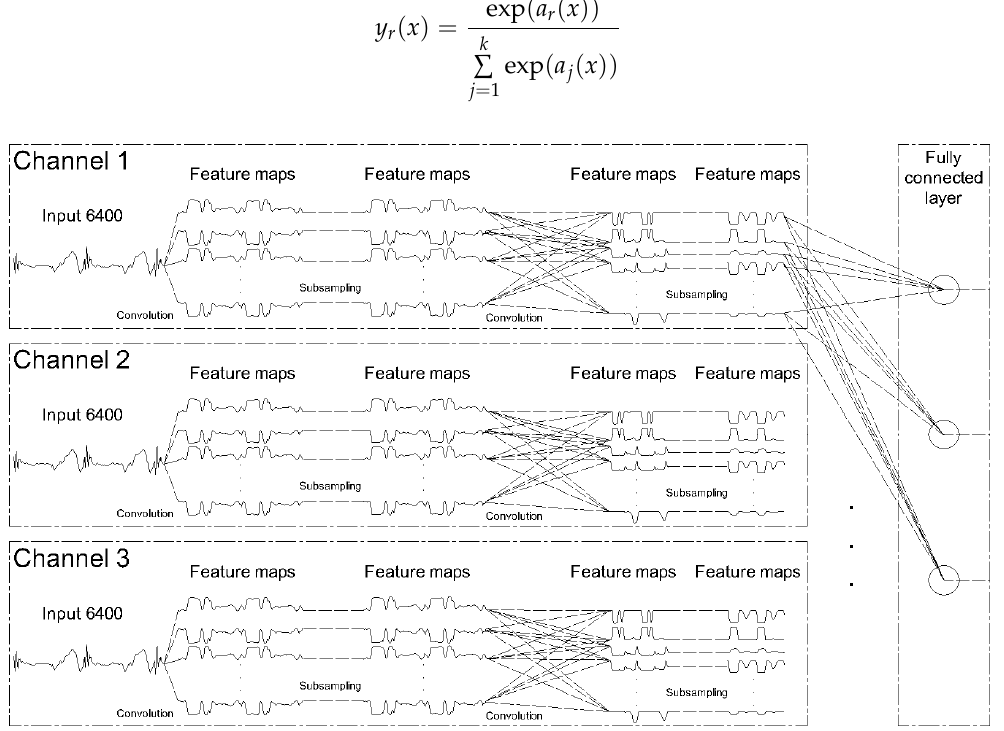
Figure 3. Two-staged modified MC-DCNN architecture with three channels